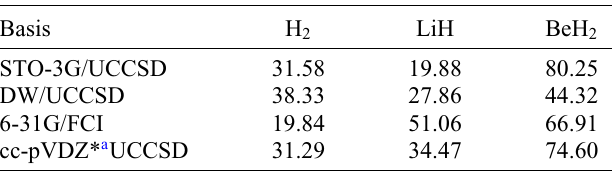
TABLE II. Nonparallelity errors (NPEs) in unit of mHatree for different basis sets. NPE is defined as the absolute difference between the maximum and minimal errors with respect to a refer- ence on a given potential energy curve. The used reference here is the largest affordable Gaussian basis set of cc-PVTZ shown in Fig. 1.